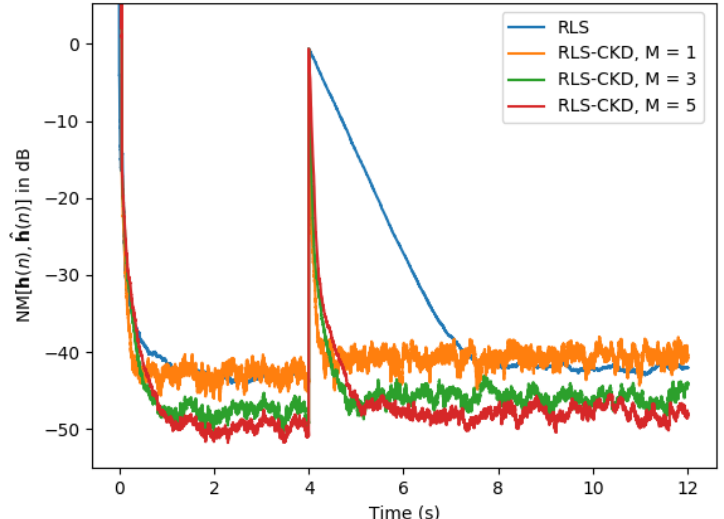
Figure 8. Normalized misalignment of the classical RLS ( L = 512) and RLS-CKD ( L 1 = 64, L 2 = 8) algorithms. The input signal is an AR(1) process and the impulse response changes after 4 s of simulation.